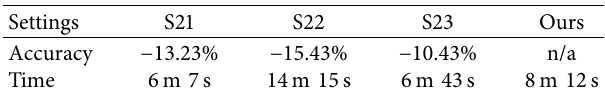
Table 8: Accuracy decrement ( − )/increment (+) and time cost of different algorithms on